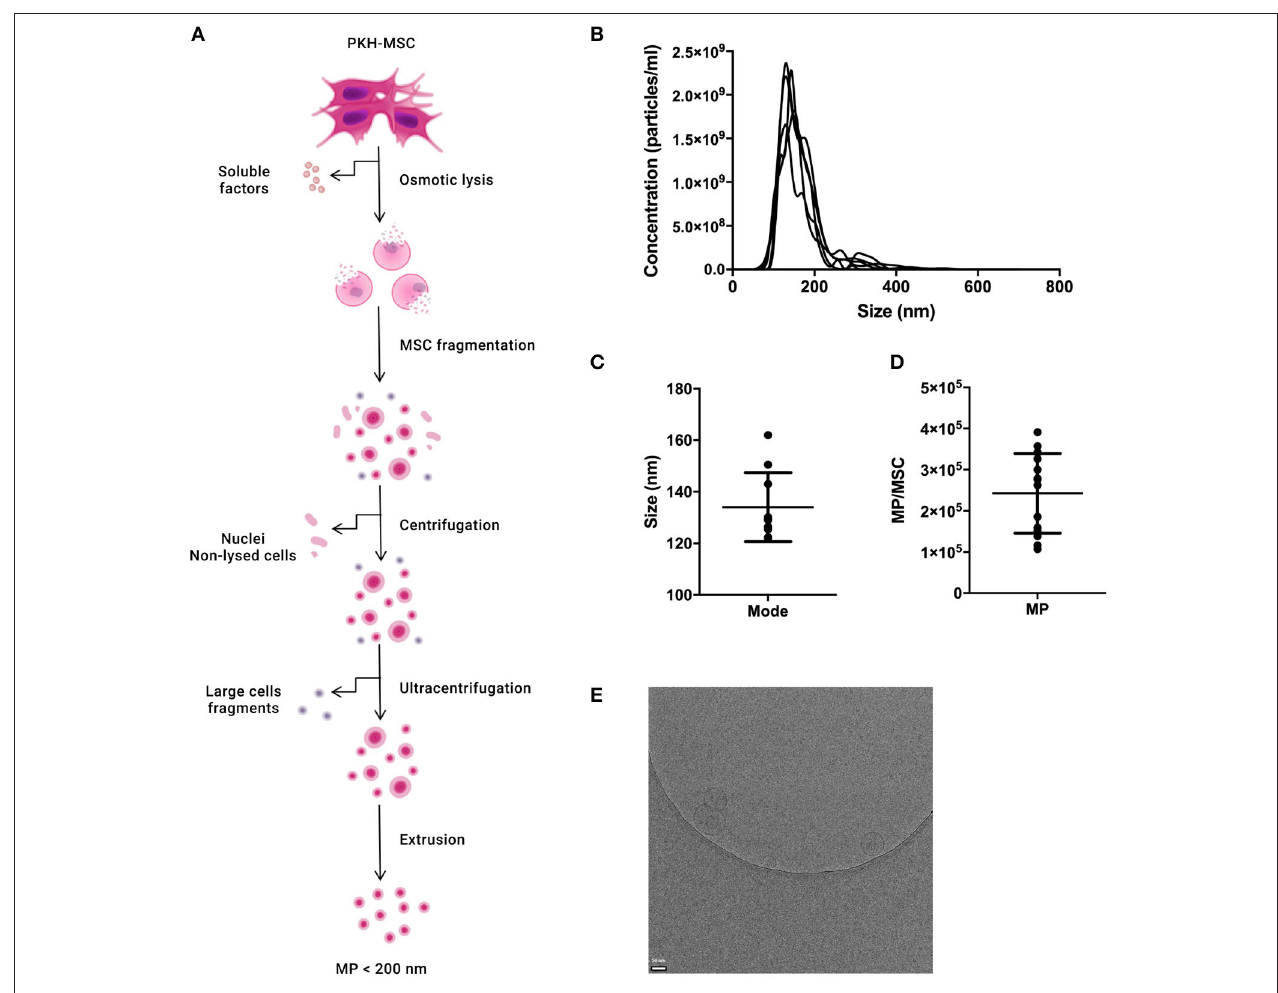
FIGURE 1 | Characterization of reconstructed membranes (MP) generated from MSC. (A) Schematic overview of the generation of MP. (B) Nanoparticle tracking analysis (NTA) profile of MP. (C) MP size distribution. (D) Number of MP generated per MSC. (E) Cryo-electron microscopy image of MP. MP (arrow) show a spherical shape and a visible lipid bilayer. Data in C and D are presented as mean ± SD from 12 independent preparations of MP.